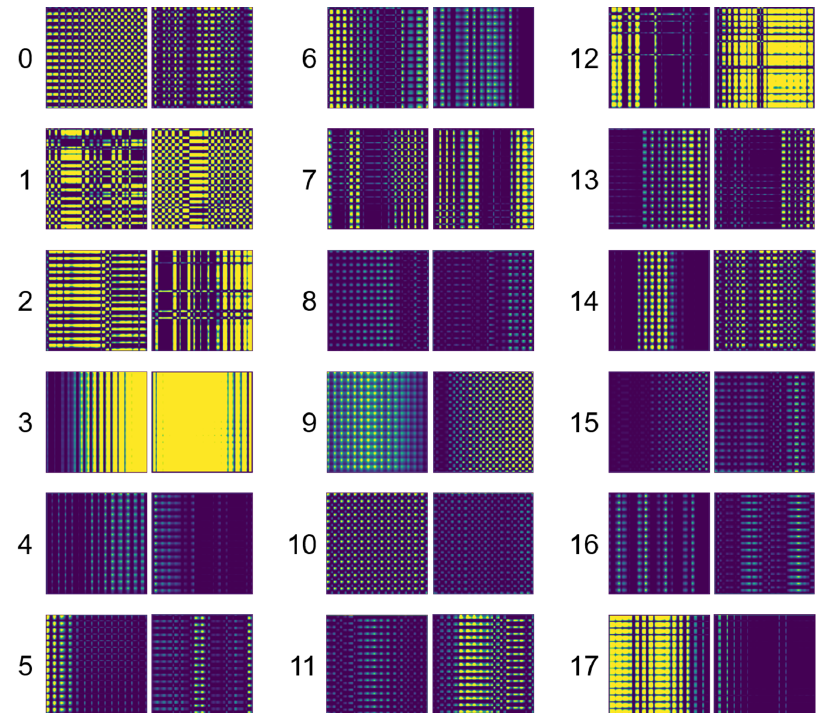
Figure 4. 𝑆𝐵𝐼𝐷𝑃 example of 18 activities in the WISDM dataset.